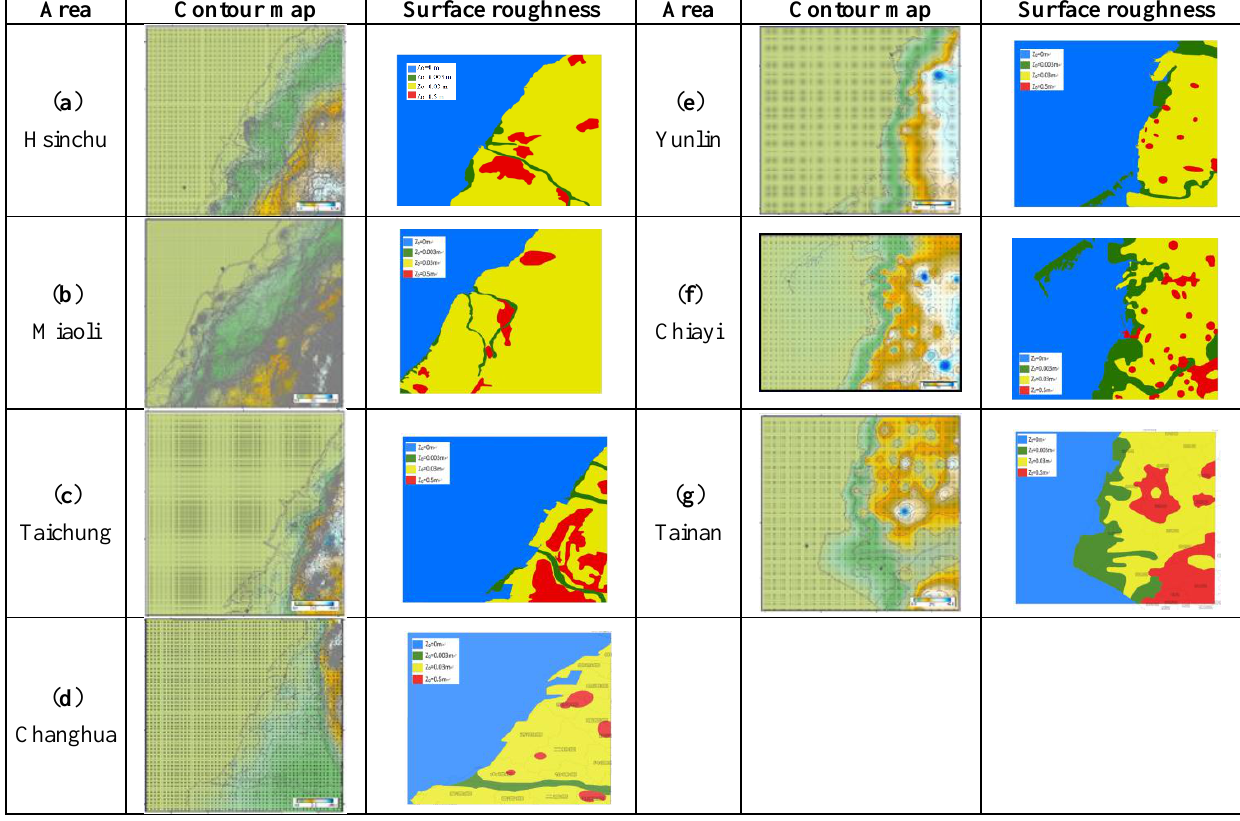
Figure 7. Contour map and surface roughness in the simulation